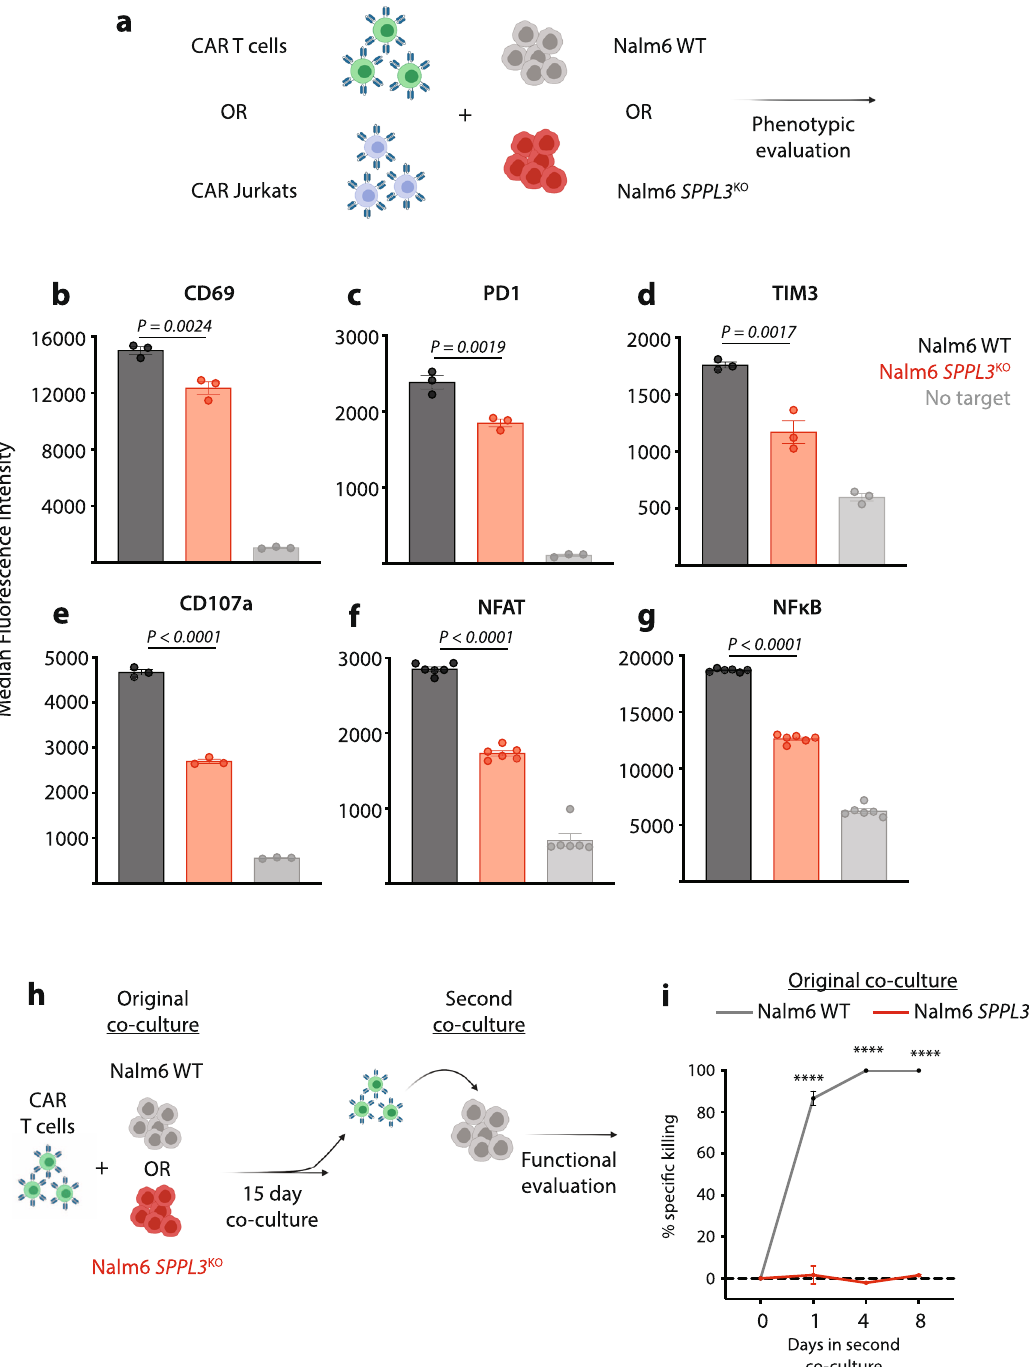
Fig. 2 SPPL3 KO suppresses CD19 CAR T cell activation. a Schematic of T cell activation studies. b – d , Expression of b CD69, c PD1, and d Tim3 on T cells after overnight co-culture with WT or SPPL3 KO Nalm6 cells or alone (control). e expression of CD107a on T cells after a 4-h co-culture with WT or SPPL3 KO Nalm6 cells. f , g Expression of f GFP and g eCFP, re fl ecting binding of NFAT and NF κ B to their respective promoter sites in CD19 CAR-expressing Jurkat cells. h Schematic of long-term co-culture and re-challenge study. i Survival of WT Nalm6 over time after the combination of CART19 cells previously cultured with either WT or SPPL3 KO Nalm6 cells. b – e , i Representative of n = 2 individual experiments with distinct donor T cells. f , g representative of n = 4 individual experiments. Error bars re fl ect mean ± standard error of the mean (s.e.m.). **** P < 0.0001 by two-way ANOVA with Bonferroni correction for multiple comparisons. Source Data are provided as a Source Data fi